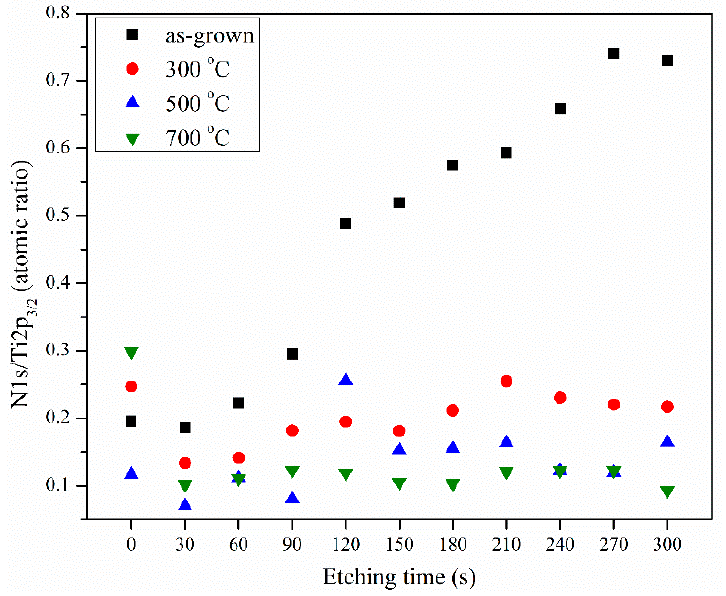
Figure 8. N1s/Ti2p 3/2 atomic ratio as a function of etching time of as-grown and annealed TiN films.